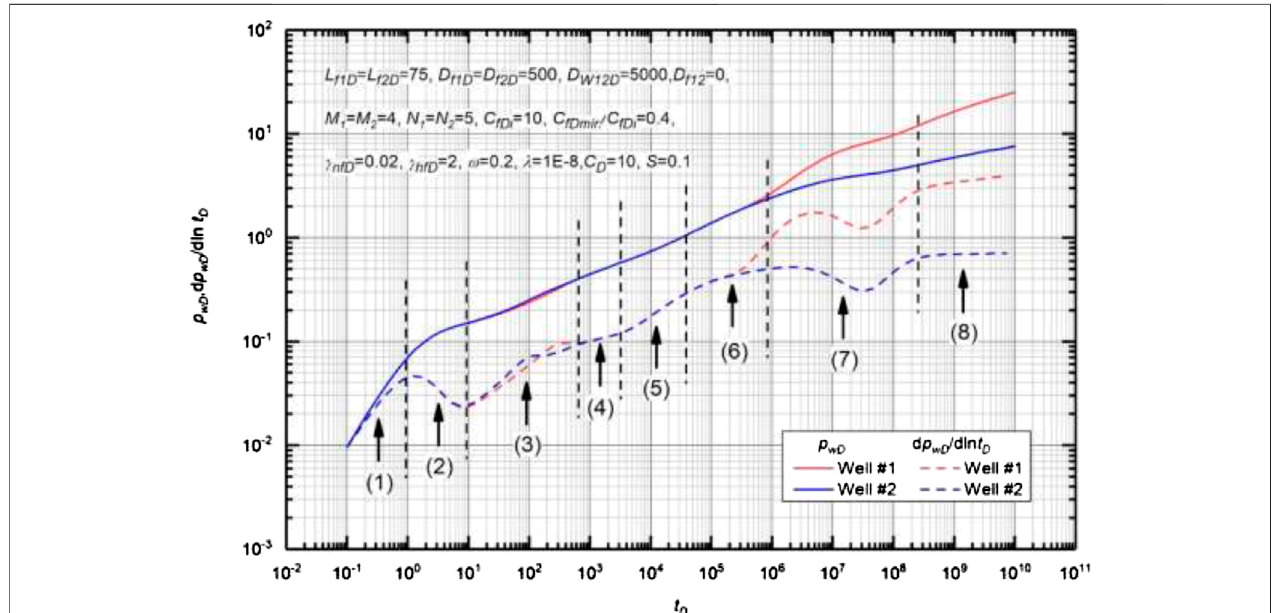
FIGURE 6 | Flow regimes of a multi-well pad with multiple fractures identi fi ed by the type curve.